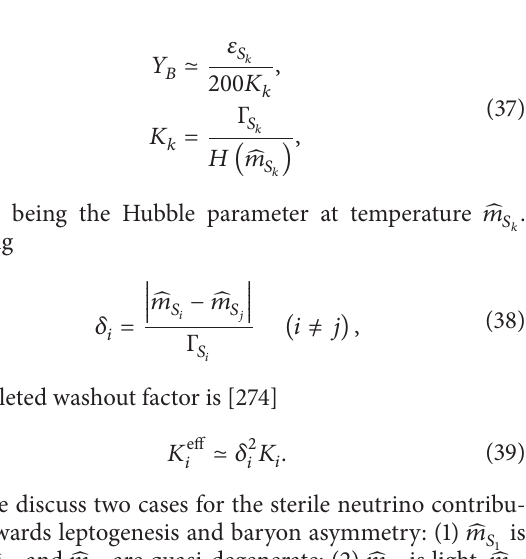
Figure 9: Tree and one-loop diagrams for the 𝑆 푘 decay contributing to the CP asymmetry. All fermion-Higgs couplings in the diagrams are of the form 𝑉ℎ where ℎ = 𝑁 − 𝑙 − Φ Yukawa coupling and 𝑉 ≃ 𝑀/𝑀 푁 .